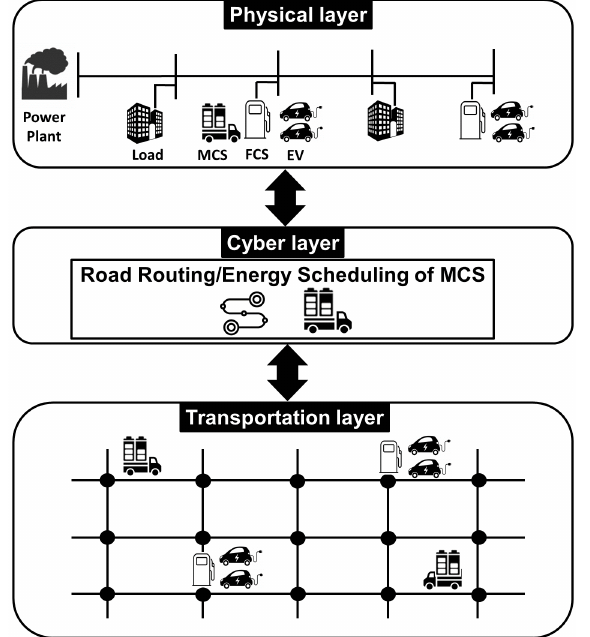
Figure 1. A three-layer architecture for the proposed mobile charging station (MCS) control frame-